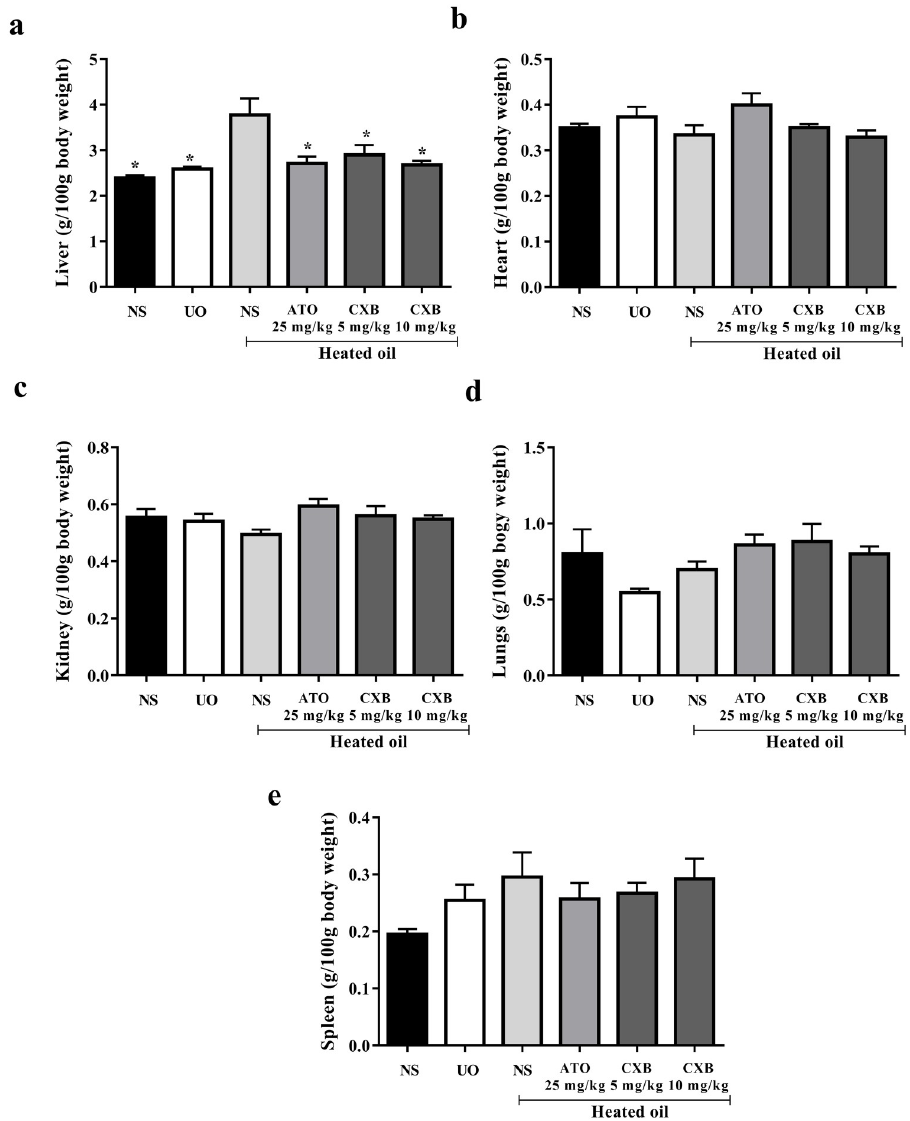
Fig 2. Effect of celecoxib (CXB 5 and 10 mg/kg) and atorvastatin (ATO 25 mg/kg) on the weight of (a) liver, (b) heart (c) kidney (d) lungs and (e) spleen in heated-oil induced hyperlipidaemia model in Sprague-Dawley rats. Values are expressed as mean ± SEM (n = 6). The symbol � represents significant differences between treatment groups and heated oil only group ( P < 0.05) (all were compared using one-way ANOVA followed by Newman-Keuls’ post hoc